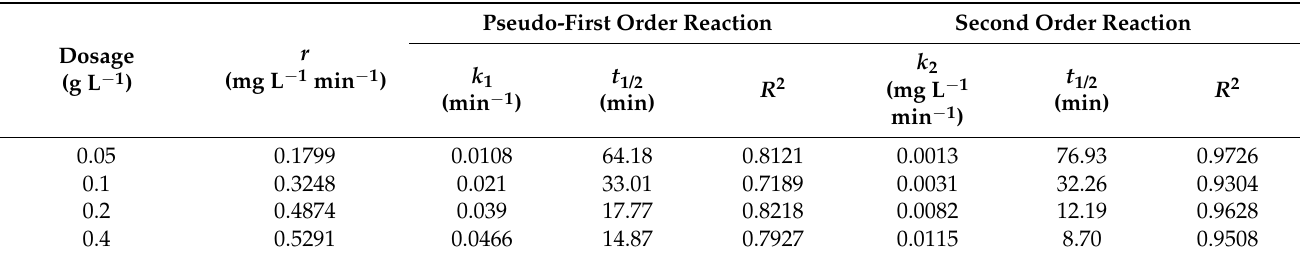
Table 1. Kinetic Parameters Based on the Plasmonic Photocatalytic Reaction of Ag/AgCl with Methylthioninium Chloride Under Visible Light Using Various Ag/AgCl Dosages 1 .